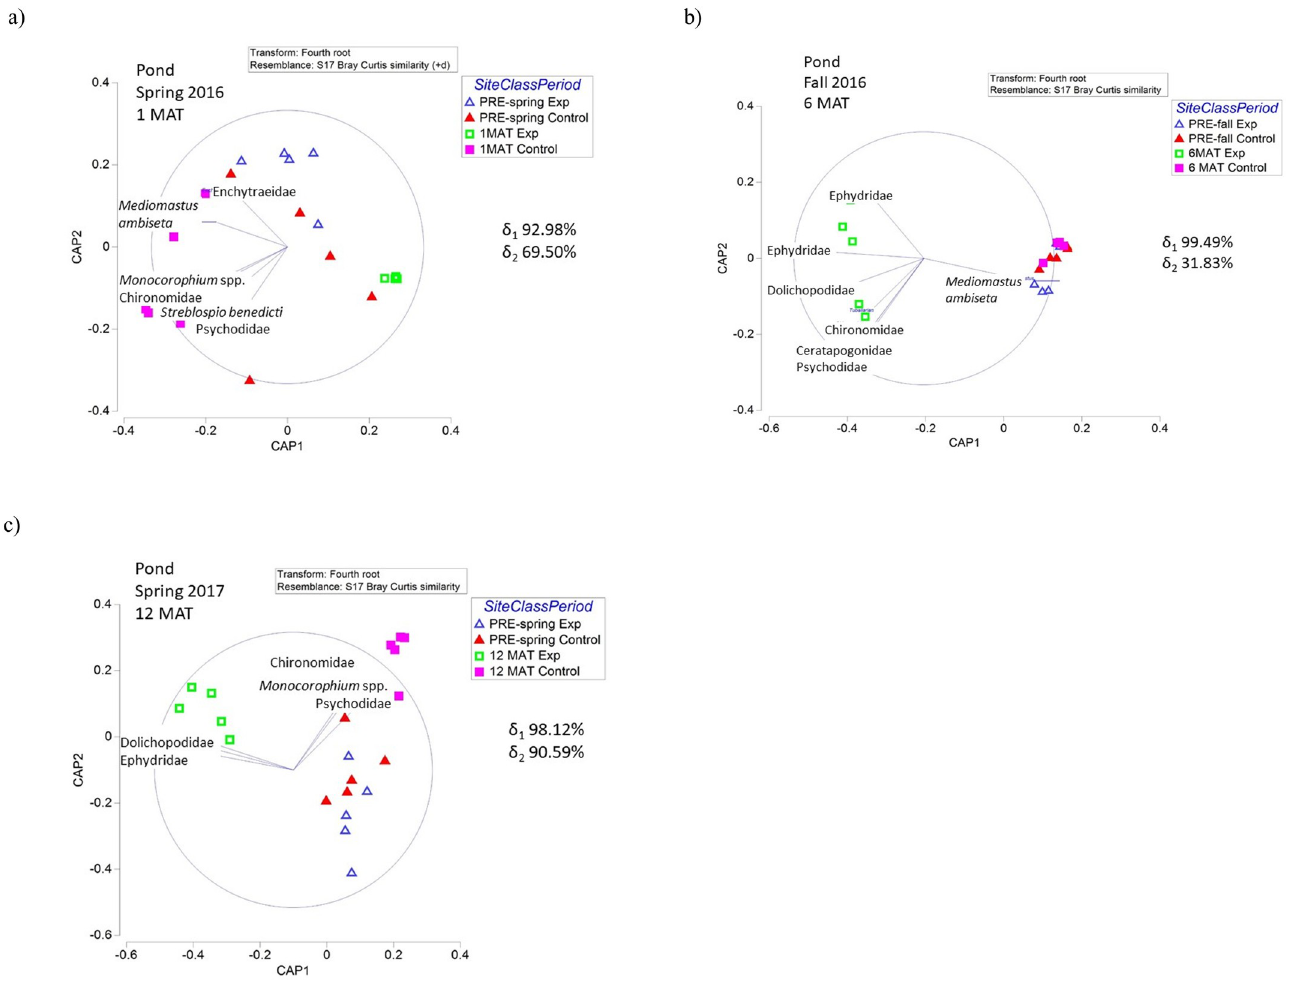
Fig 9. Infaunal invertebrate CAP plots showing the change in community composition of invertebrates for each sampling season (a,b,c) in Pond habitats compared to pre-sediment application data. Canonical correlation values ( δ ) for each axis are reported to show strength of the association between the multivariate data cloud and the hypothesized group differences. Habitats are abbreviated as follows: Spartina foliosa -dominated (Spfo), Batis maritima- dominated (Bama), and ponds or standing water (Pond). Exp is the experimental sediment application area/site. MAT is months after